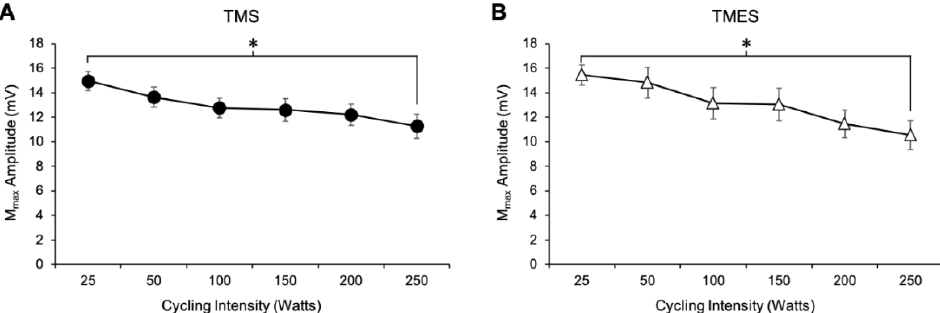
Figure 5. Changes in M max amplitudes with increasing power output pooled between stimulation intensities for the TMS ( A ) and TMES ( B ) session. * denotes significant main effect of power output on M max amplitude. M max decreased by approximately 24.9 and 31.7% as power output increased from 25 to 250 W for the TMS and TMES sessions, respectively.